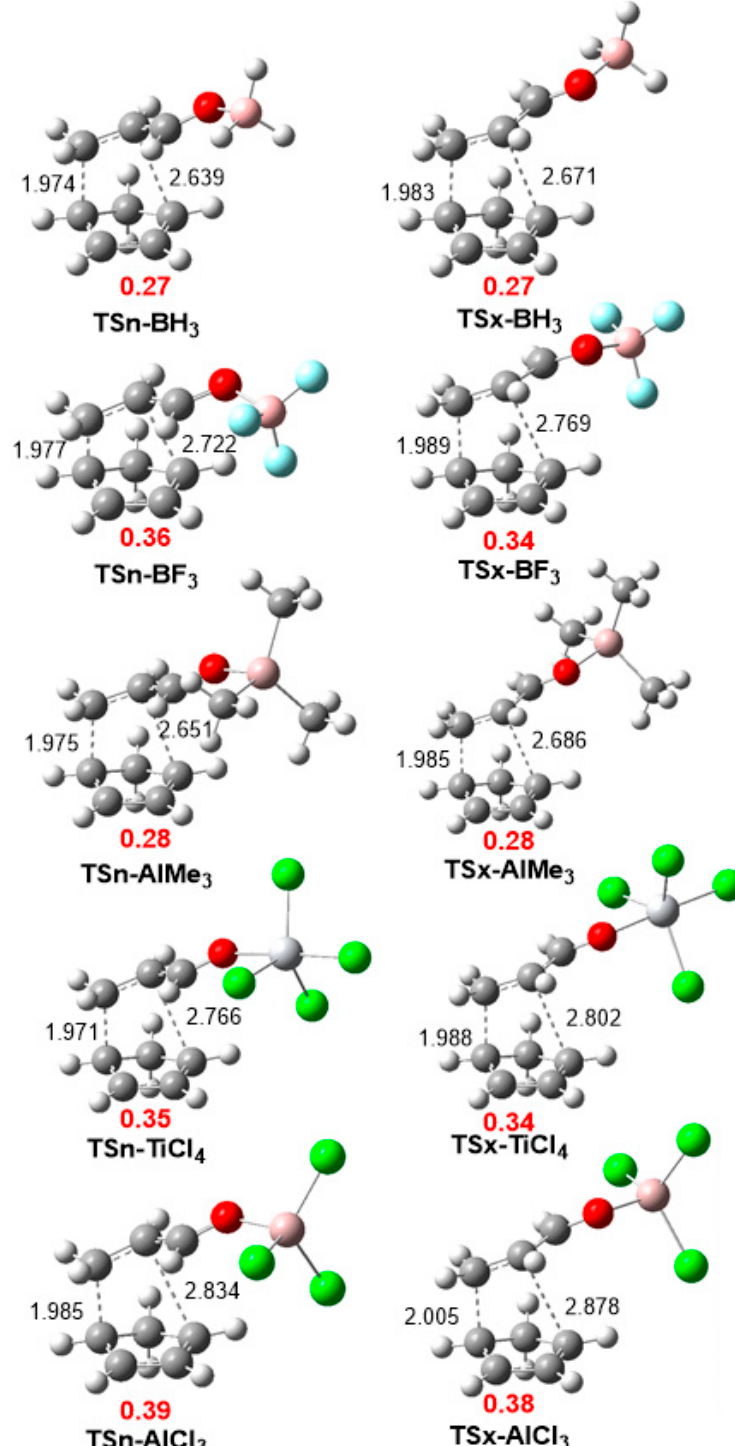
Figure 5. B3LYP / 6-311G(d,p) gas phase geometries of the stereoisomeric transition state structures (TSs) involved in the P-DA reactions of Cp 1 with the series of LA complexes. Distances are given in angstroms, Å. The GEDT values, in average of electrons e, are given in red. As expected, a very good linear correlation between the activation energies and the GEDT computed at the six TSs is found, R 2 = 0.94 (see Figure 6). The values associated to the 32CA reaction of Cp 1 with ethylene 5 and acrolein 7 are also included. When the non-polar DA reaction with